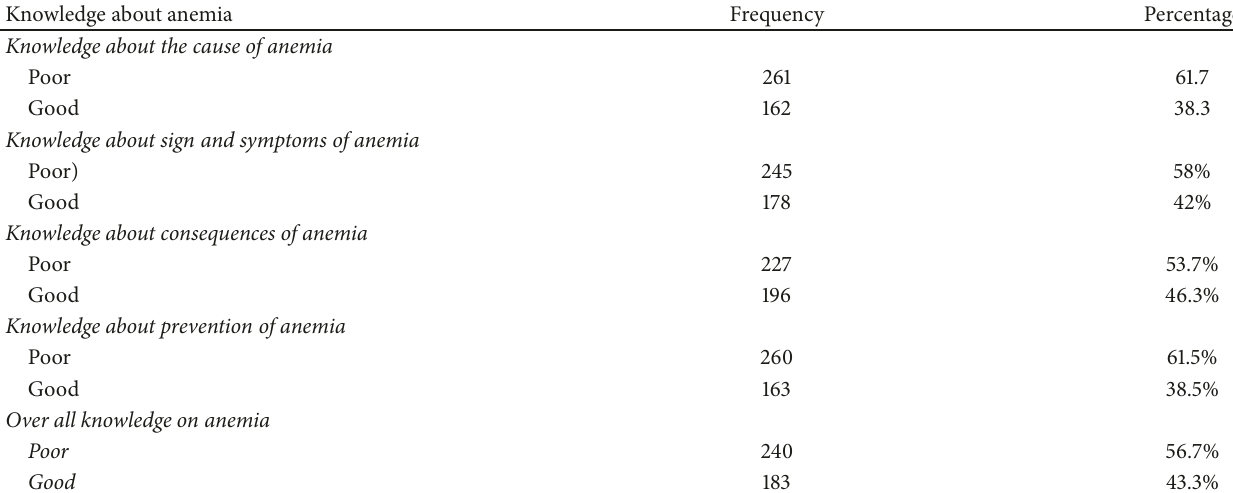
Table 2: Knowledge about Anemia among school adolescent girls at rural towns’ elementary and secondary schools of Bahir Dar city Administration, 2017